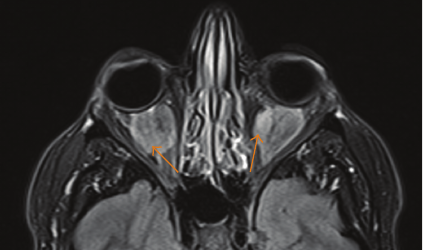
Figure 5: A 35-year-old male with axial T2-weighted FLAIR image showing heterogeneously hyperintense soft tissue lesions (arrow) in the intra- and extraconal retrobulbar space.